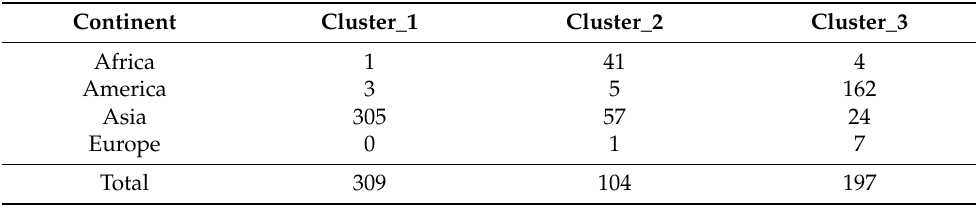
Figure 2. The population structure and the genetic relationship among the three clusters in the C. moschata germplasm collection. ( a ) The upper dendrogram was produced using the UPGMA method based on the genetic dissimilarity among the 610 germplasm accessions. Seven groups from the entire collection were distinguished in the gray color bar under the tree. The bar plots from the STRUCTURE analysis were listed in the order that is the same as the dendrogram under the tree. The Q-values of each clusters per accession were distinguished with different colors. Cluster 1 is in red, cluster 2 is in green, and cluster 3 is in blue. ( b ) The PCA of the entire collection colored by the clusters. ( c ) The F ST values among the three clusters. Table 1. Origin of the C. moschata germplasm collection among the three clusters inferred by the STRUCTURE